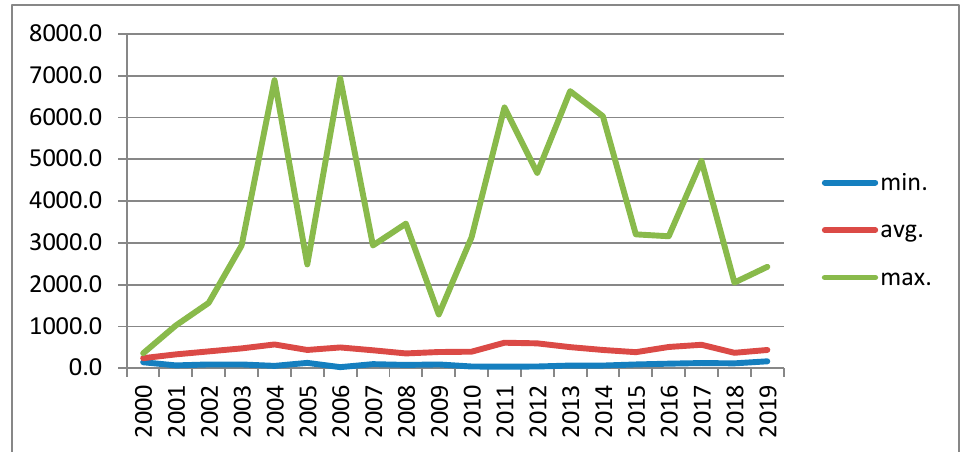
Figure 4. Annual wood prices [USD/m 3 ] of Sycamore wood offered at the Krosno submission.